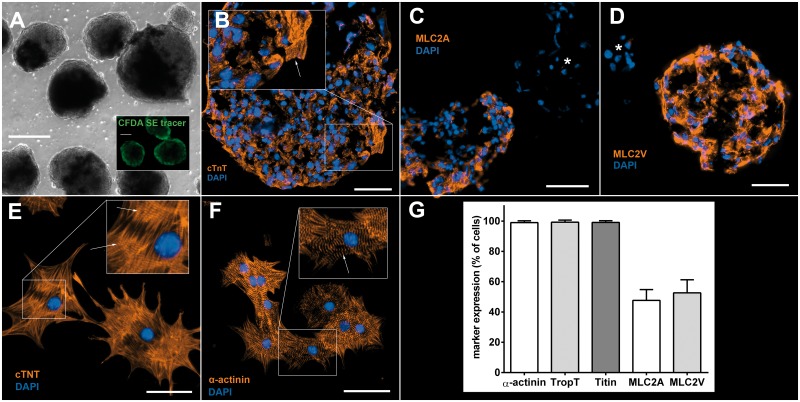
Cardiac bodies and cardiomyocytes derived from murine iPSCs.A: CBs after antibiotic selection (dd14, brightfield view); inset: CBs after CFDA SE tracer staining (dd14). Scale bars: 100μm. B: CBs are positive for cTNT and show CMs with sarcomeric striations (inset, arrow). Scale bar: 50μm. C+D: CBs at dd14 are positive either for MLC2A or MLC2V indicating spontaneous differentiation into both an atrial and ventricular phenotype; negative CBs are marked with *, respectively. Scale bars: 50μm. E+F: Reseeded CMs exhibit a mature sarcomeric intracellular organisation. Staining for cTnT and α-sarcomeric actinin shows Z-lines (arrows). Scale bars: 50μm. G: Relative amount of reseeded CMs expressing cardiac markers α-sarcomeric actinin (99.1±1.5%), cTnT (99.3±0.4%), Titin (99.4±0.3%), MLC2A (47.3±1.9%) and MLC2V (52.1±1.8%); N = 8.